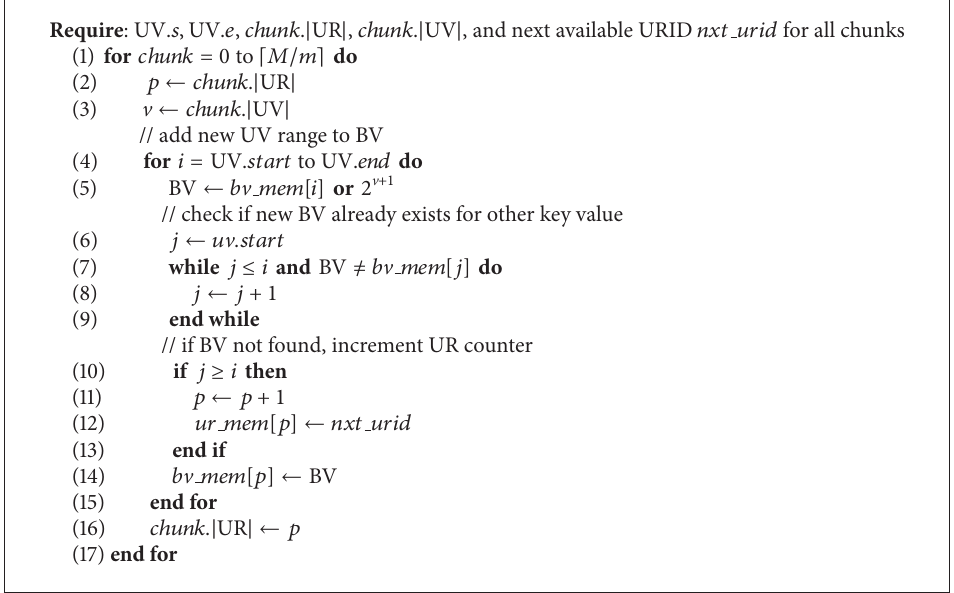
Algorithm 2: Incremental update algorithm for